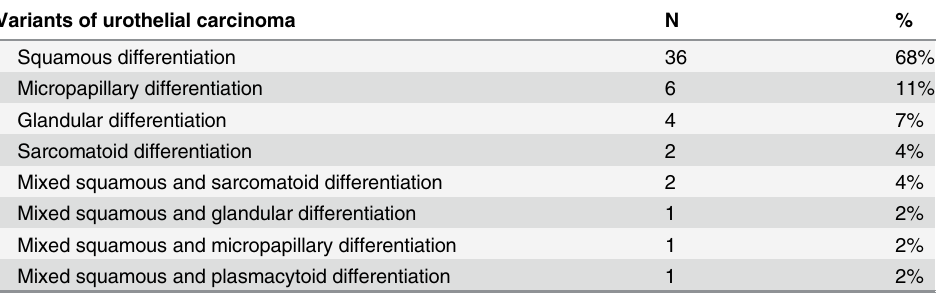
Table 2. Distribution of histopathological variants.